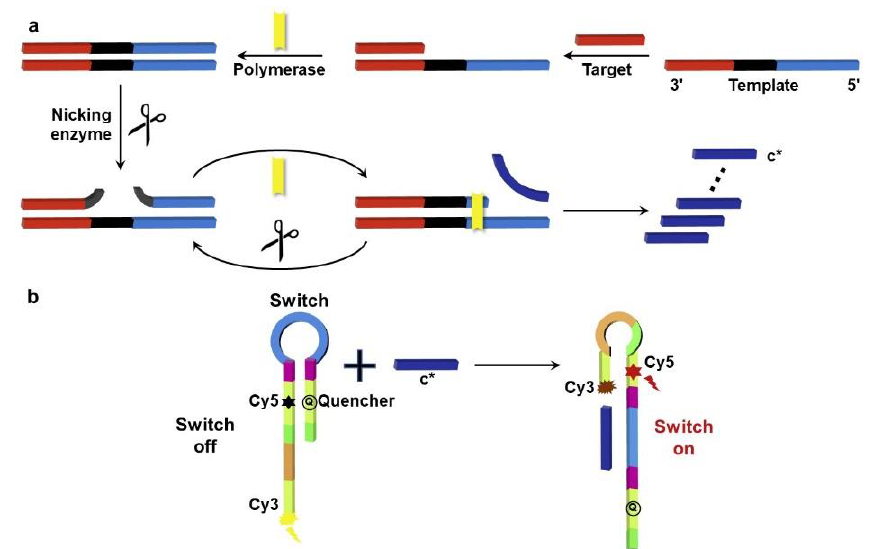
Figure 3. (a) Switch-conversional ratiometric fluorescence biosensor for miRNA let-7a detection, (b) illustration of exponential amplification reaction (EXPAR) and switch conversion. Reproduced with permission from Ref. [60]. Copyright 2020, Elsevier.